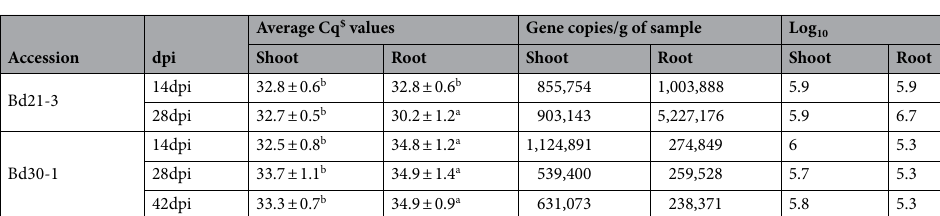
Table 1. Determined Cq values and gene copy number of B26 leaf and root samples of Bd21-3 and Bd30-1 inoculated with B26. $ Cq values -quantification cycle (Cq). a,b Letter to represent the significant difference. Means with same letters are not significant, while means with different letters are significant within column according to Independent Student t-Test ( p < 0.05).